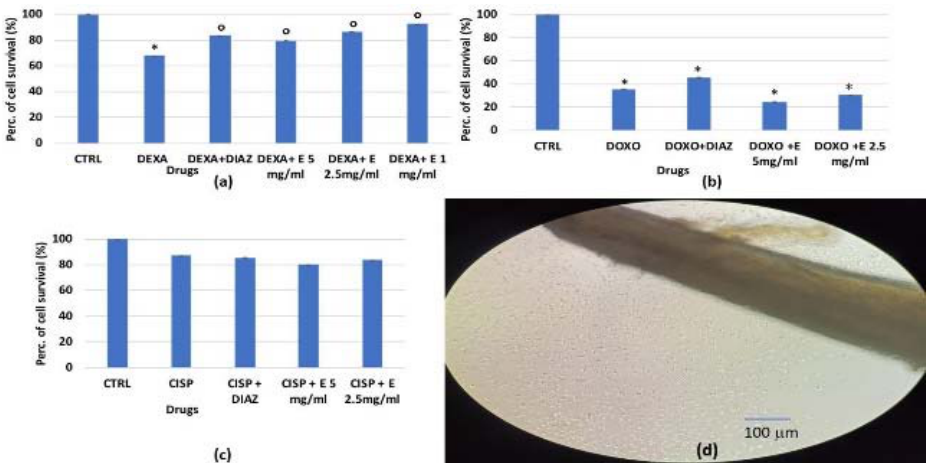
Figure 2. Percentage change in cell growth values for osteoblasts after 24 h of incubation with: ( a ) dexamethasone 2 × 10 − 6 M (DEXA), ( b ) doxorubicin 1 × 10 − 6 M (DOXO), ( c ) cisplatin 1 × 10 − 4 M (CISP), and diazoxide (DIAZ) (250 × 10 − 6 M) or the extract (E) at different concentrations in the crystal violet assay. ( d ) Image of murine osteoblasts migrating from bone fragments at 90% confluency. The reported values represent an average of at least six replicates. One-way analysis of variance with ANOVA was performed to determine the significance of the data vs. controls (CTRL) * or cytotoxic compounds ◦ with a value of p < 0.05.